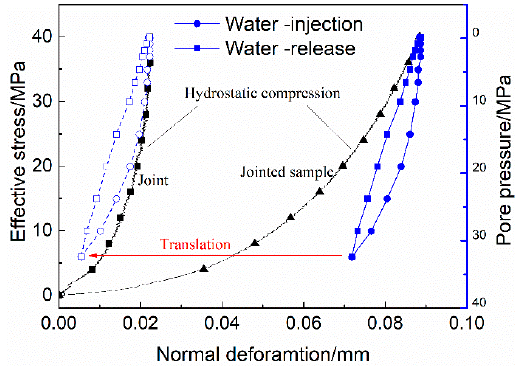
Figure 7. The relative normal deformation of jointed sample during the water injected in pressure balanced injection.